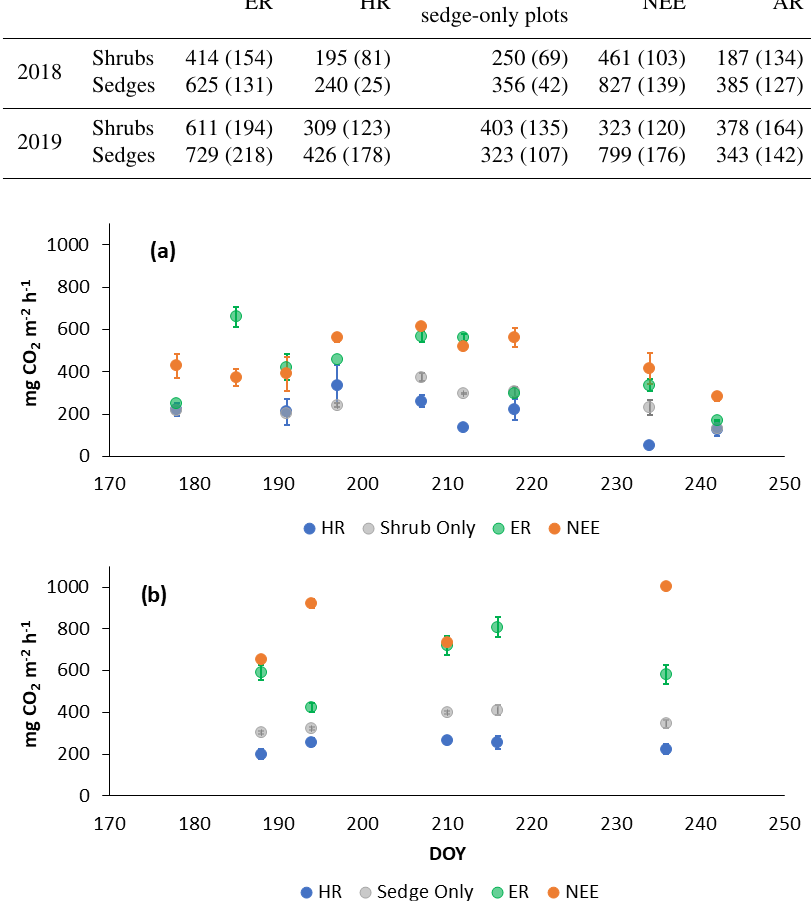
Figure 3. Average CO 2 fluxes in the (a) shrub plots and (b) sedge plots across the growing season of 2018 ( ± standard error).